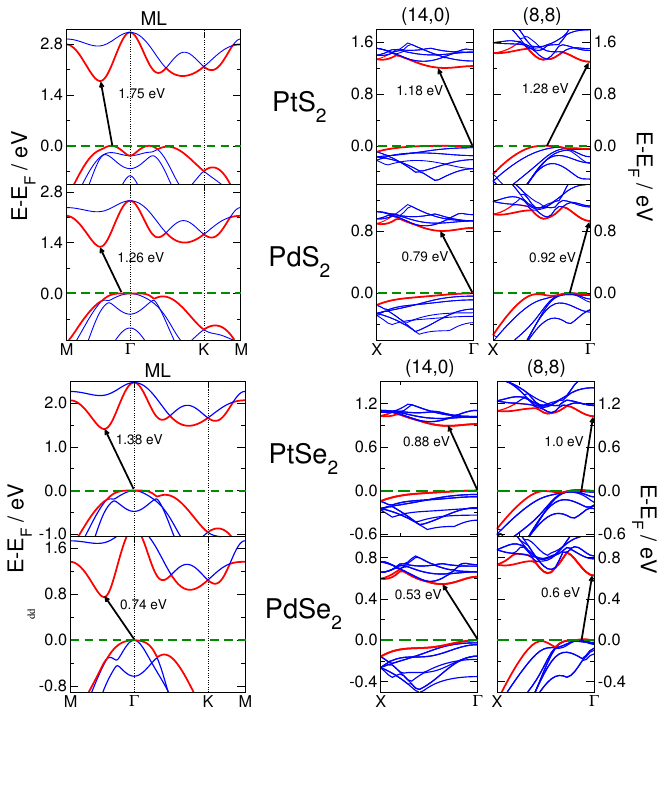
Figure 5. Band structures of monolayers, (32,0), (18,18) nanotubes of MX systems,